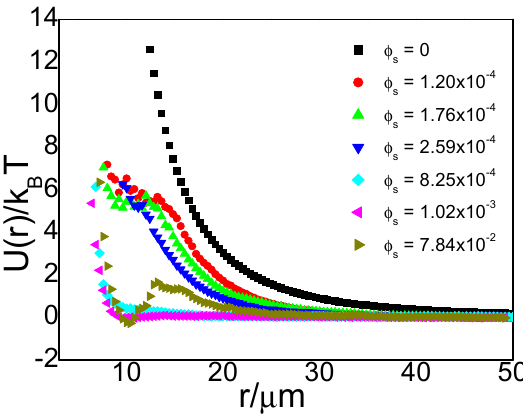
Figure 4. Pair-wise potential U(r) of 1-µm PS particles in binary-charged system with different small 0.21-µm PS particle concentration.